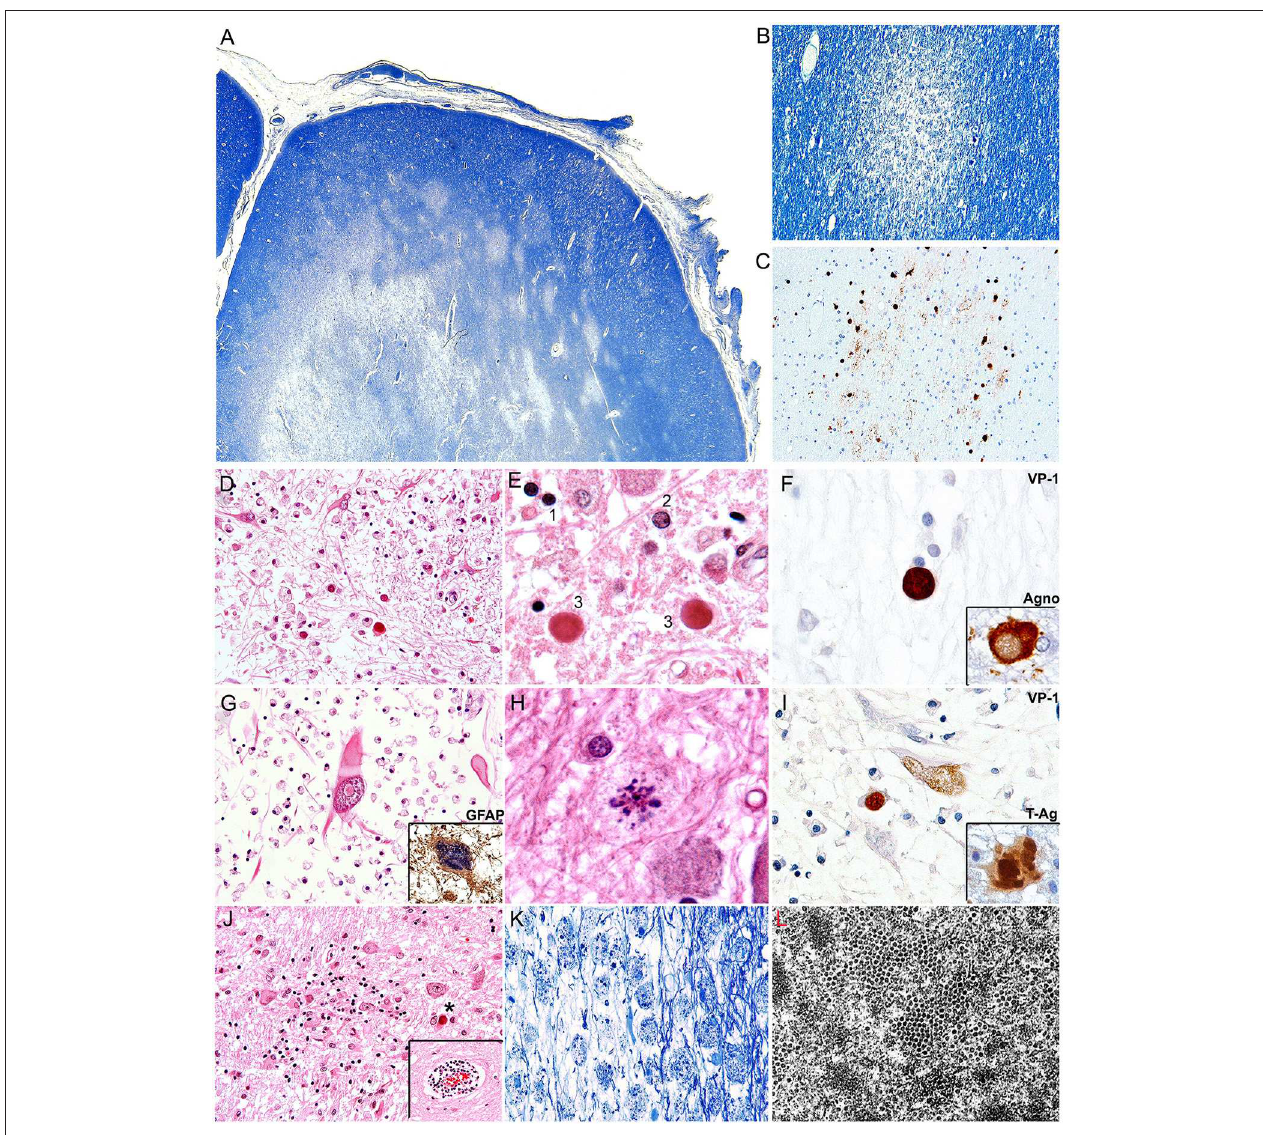
FIGURE 2 | Histopathological features of PML. (A) Montage of a frontal lobe gyrus in a case of PML demonstrates extensive plaques of demyelination in the subcortical white matter (Luxol Fast Blue, 40x magnification). (B) At higher magnification, an early plaque shows well defined borders (Luxol Fast Blue, 100x magnification). (C) A consecutive section shows the same plaque or demyelination immunolabeled with a VP1 antibody, which highlights JCPyV infected oligodendrocytes in the periphery of the plaque (Original magnification 100x). (D) A plaque of demyelination showing numerous enlarged oligodendrocytes in the middle and lower field, and several bizarre astrocytes in the upper field (H&E, 400x magnification). (E) At higher magnification the different types of inclusion bodies are shown; an early inclusion (2), with 2 late, intensely eosinophilic inclusions (3) in comparison with a non-infected oligodendrocyte (1) (H&E 1,000x magnification). (F) Immunohistochemistry for viral proteins shows VP1 in the intranuclear inclusion bodies of oligodendrocytes and the accessory Agnoprotein in the cytoplasm. (G) A bizarre astrocyte with elongated cytoplasmic projections and an intranuclear inclusion body is shown. (H&E 600x magnification). Immunohistochemistry for GFAP corroborates their phenotype (insert, 600x magnification). (H) Atypical mitotic figures can also be found (H&E 1,000x magnification). (I) Immunohistochemistry for viral proteins demonstrates the nuclear expression of VP1 and the nuclear and cytoplasmic expression of the early protein T-Antigen. (J) Additional histological features include microglial nodules and perivascular cuffs of lymphocytes (insert) (H&E 200x magnification), and (K) foamy macrophages that phagocyte cellular debris and myelin released by the lysed oligodendrocytes (Luxol Fast Blue, 200x magnification). (L) An electro micrography shows abundant icosahedral viral particles in the intranuclear inclusion bodies of